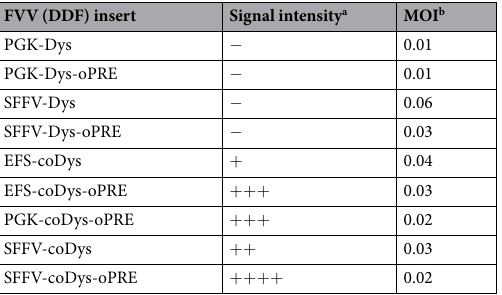
Table 2. Immunofluorescence analysis of dystrophin expression in FVV transduced HT1080 cells. a The relative dystrophin staining intensity was subjectively scored between – (no specific staining) and ++++ (strongest specific staining). Representative images are shown in Fig. S3. b Genomic DNA from the transduced cells was used to retrospectively determine the